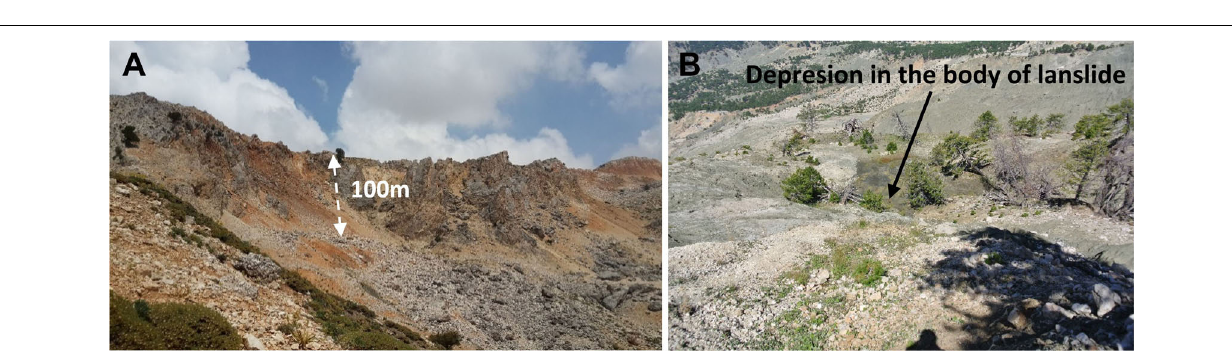
FIGURE 13 | (A) Rock slump on scarp due to slope instability. (B) Destruction of forest on Elmalı formation as a result of flow material in one of the secondary rock avalanches (in Figure 4 , viewpoints of photographs are